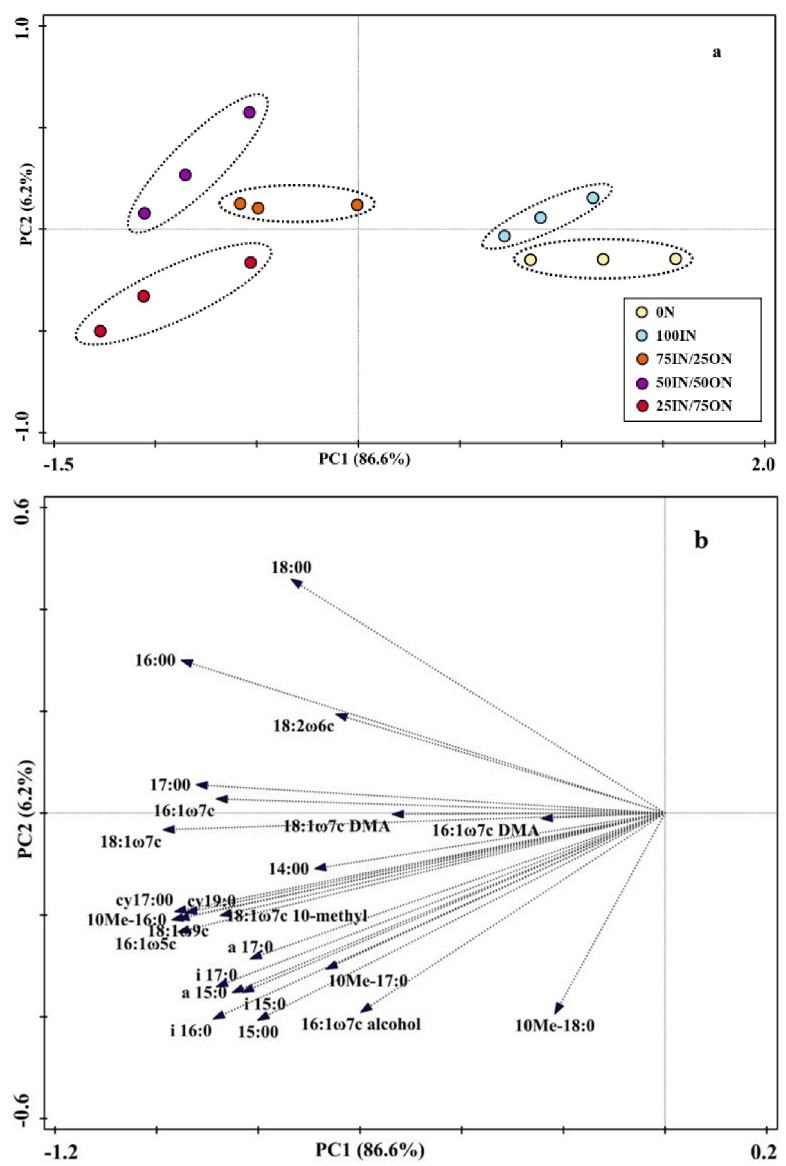
Fig 5. Principal component analysis (PCA) of soil phospholipid fatty acids (PLFAs) (a), and loading values for individual PLFAs (b) from different fertilizer treatments.